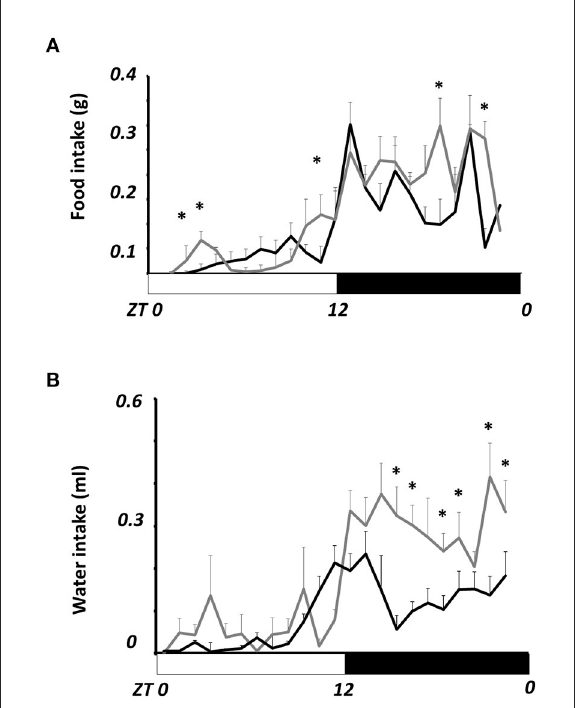
FIGURE2 Comparative daily profile of daily food (A) and water (B) intake in lean and obese N. alstoni. Data are presented as mean ± SEM, n = 10 lean, n = 5 obese. Lean (black line), Obese (gray lines). Bars depict the LD cycle. * Significant differences intergroup (two-way ANOVA, P <